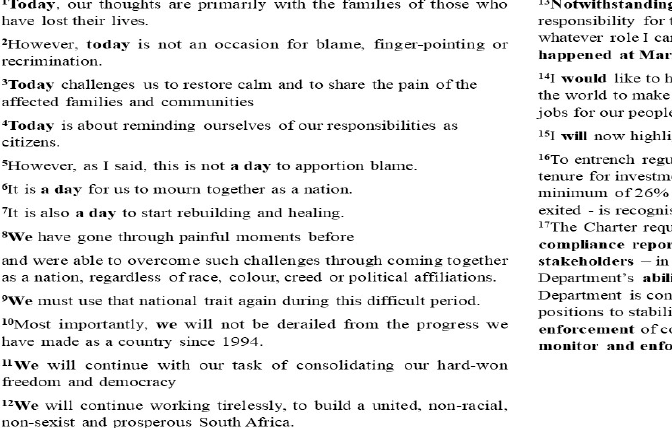
Figure A6: Textual data—analysis of storylines.